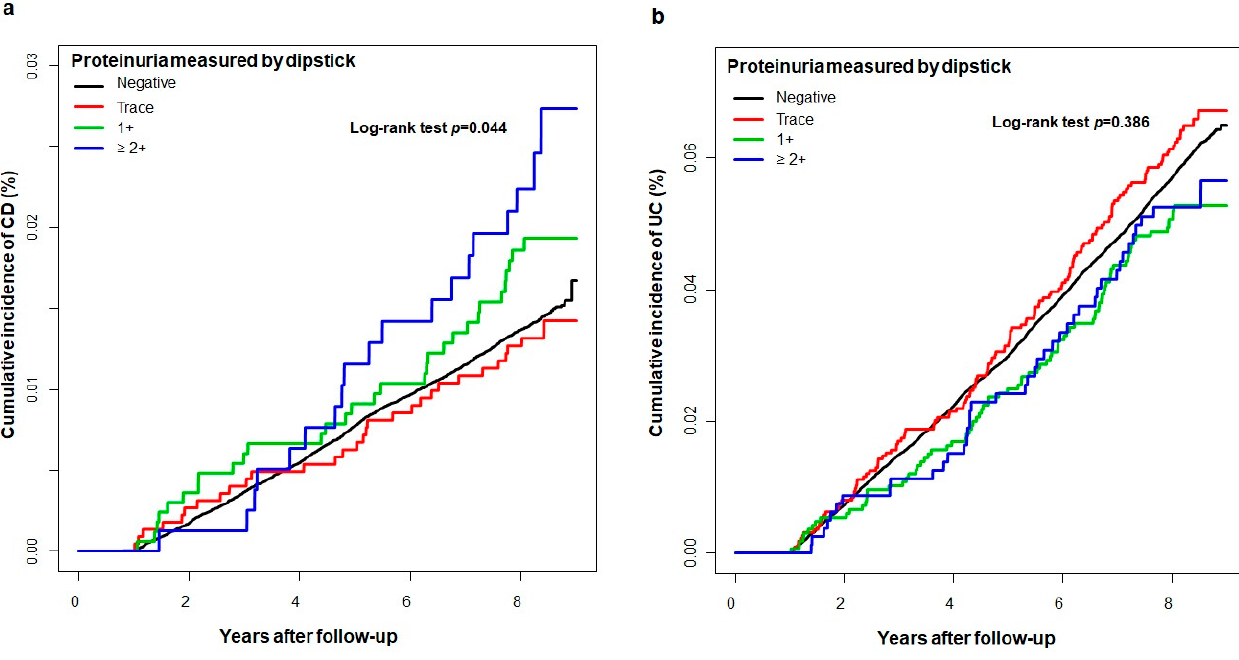
Table 3. Subgroup analysis of the risk of Crohn’s disease and ulcerative colitis among people with dipstick-positive pro- teinuria. Subgroup